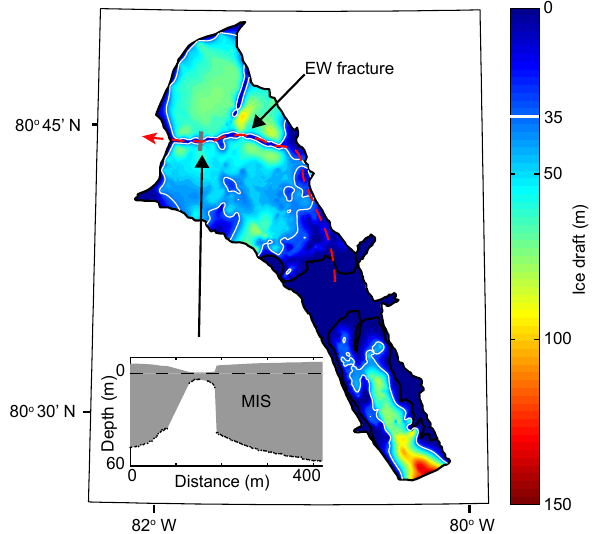
Figure 3. Map of the draft of ice in Milne Fiord indicating the likely drainage pathway of the MEL along a re-healed fracture in the MIS. The modelled ice draft is that presented in Hamilton (2016) from ground-based, aerial, and satellite ice thickness and surface eleva- tion data assuming the ice is in hydrostatic equilibrium. The 35m contour is highlighted to show the outflow restriction the MIS im- poses across the mouth of the fjord for water above this level. The inset shows ice thickness across the basal channel from a 400m ice-penetrating radar transect that crossed the east–west re-healed fracture in July 2013 (Hamilton,